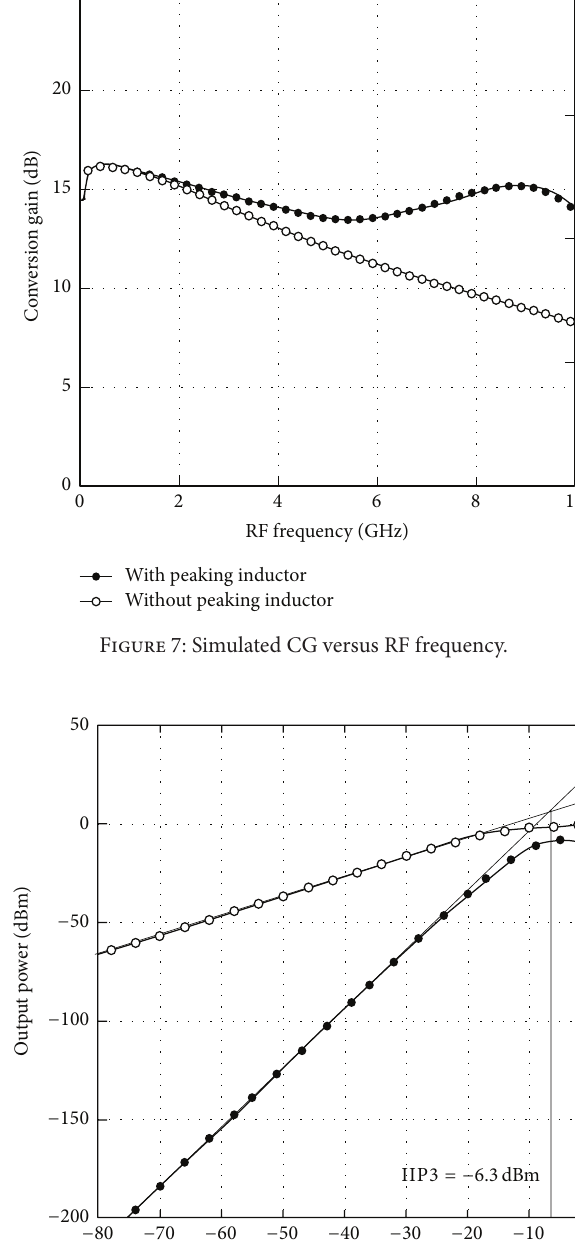
Figure 6: Simulated NF versus RF frequency.